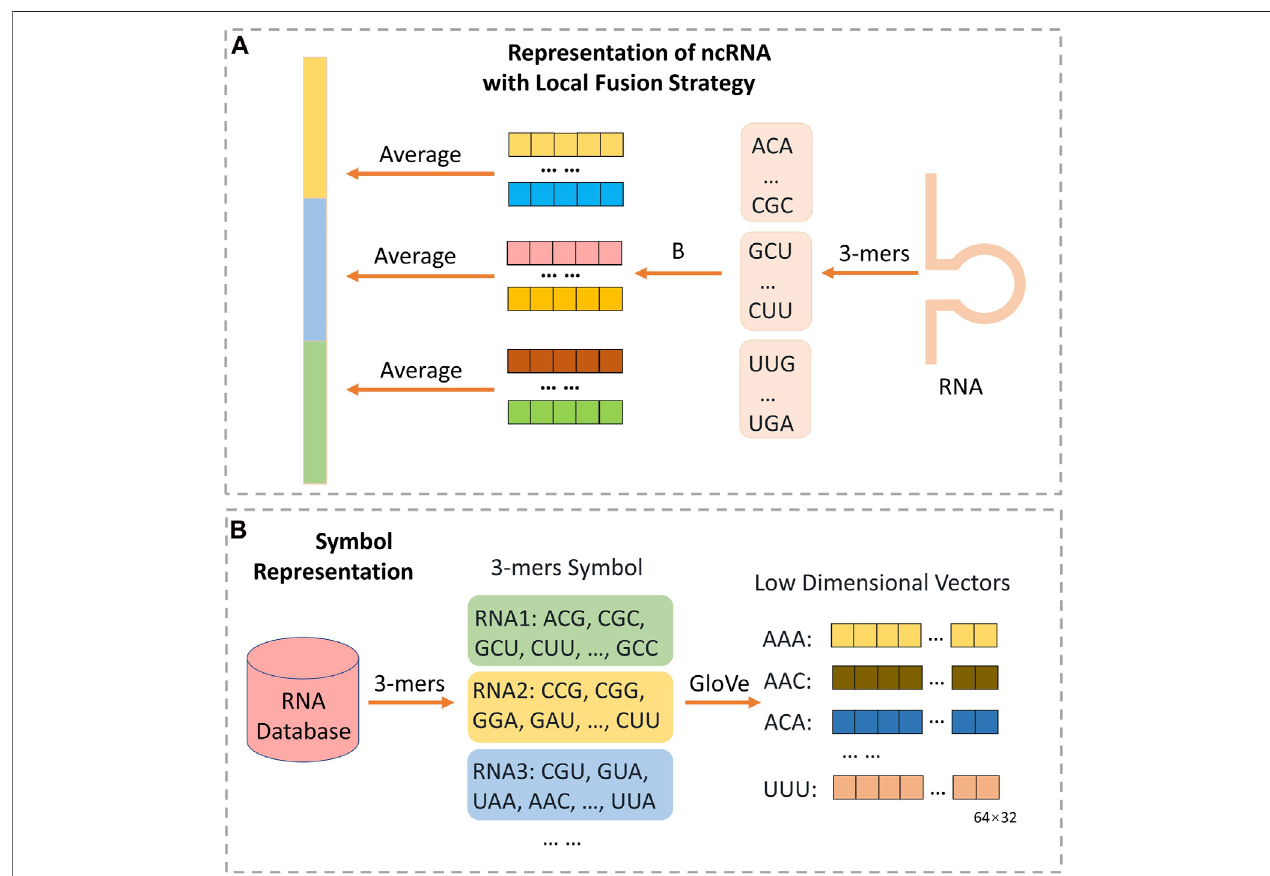
FIGURE2| The architecture for extracting ncRNA structure feature through NLP method with local fusion strategy. As (B) shown, each ncRNA from database isdivided intomany triplesymbolsby3-merscomposition, and GloVeisused togenerateembeddingvectorof4 3 symbols.Then, as (A) shown, eachncRNAwillbe split into some consecutive subsequences with no overlap. All the triple symbols embedding vector of each subsequence can be obtained from (B) . Finally, the representation of ncRNA can be obtained through calculating the average of all symbol vectors in each subsequence respectively, and concatenating all average